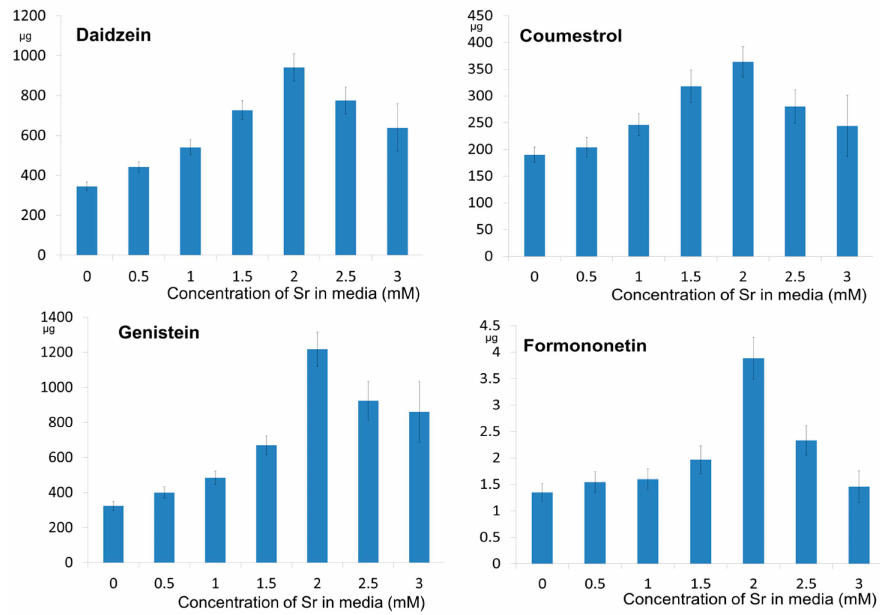
Figure 2. The effect of various strontium concentrations on the content ( µ g/plant) of daidzein, coumestrol, genistein and formononetin in Glycine max ( n =